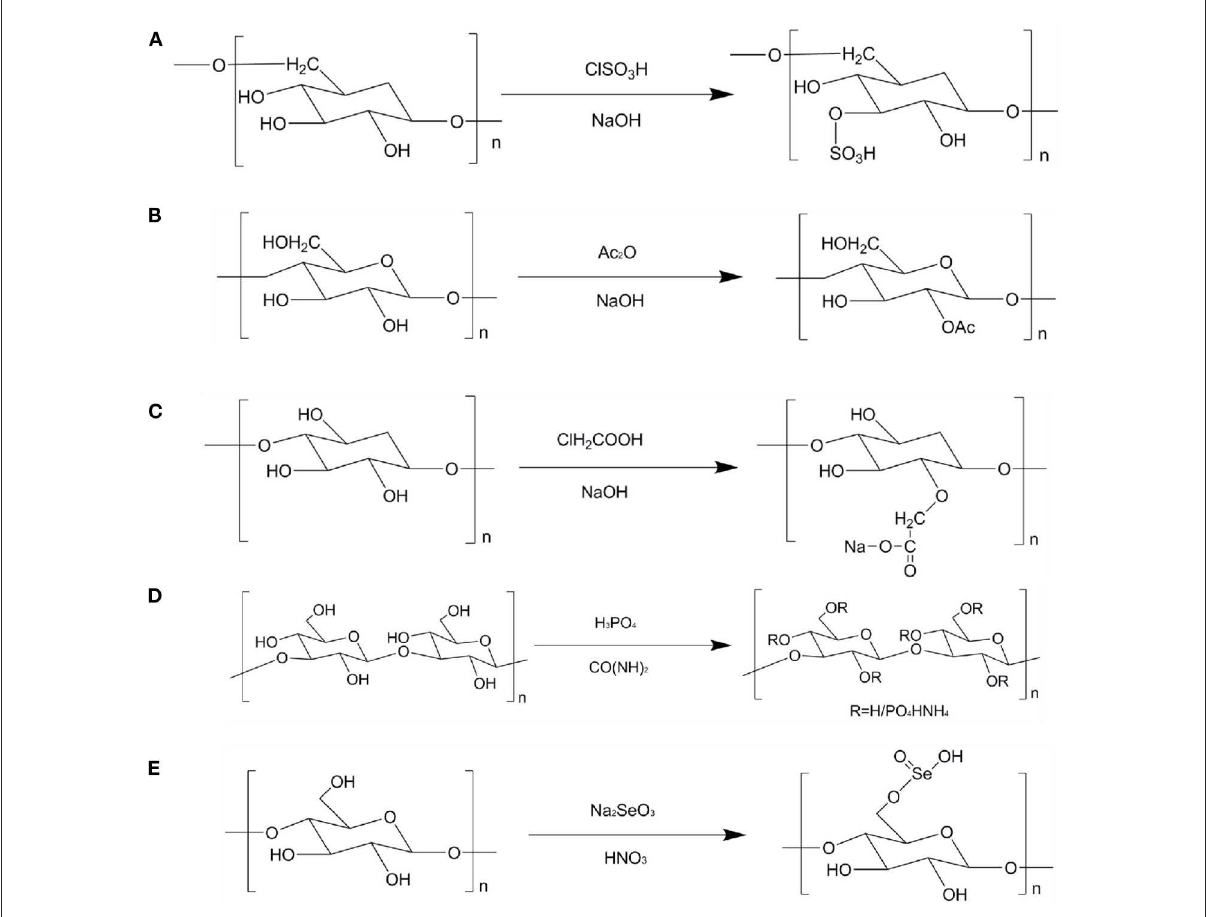
FIGURE2 Schematic diagram of different modification of TCMPs. (A) Sulfation modification; (B) acetylation modification; (C) carboxymethylation modification; (D) phosphorylation modification; (E) selenium